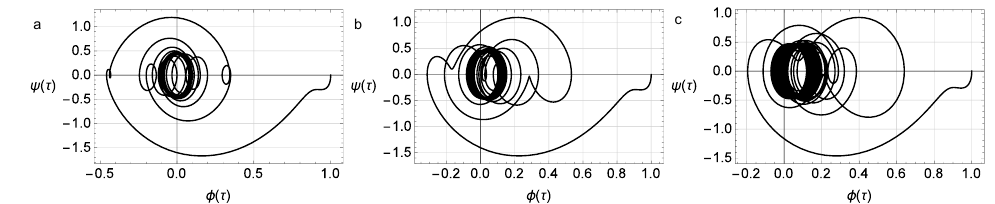
Figure 16. The phase portrait ( ϕ ( τ ) , v ( τ )) at different values of the coefficient at the hysteresis term; ω = 1.2, K = 2, Ω = 5, and σ = 1.5. Parameters of the Bouc–Wen model: A = 1, β = 0.1, γ = 0.9, and n = 3, initial conditions ϕ ( 0 ) = 1, v ( 0 ) = 1, and ( a ) H = 0.0, ( b ) H = 0.5, or ( c ) H = 1.